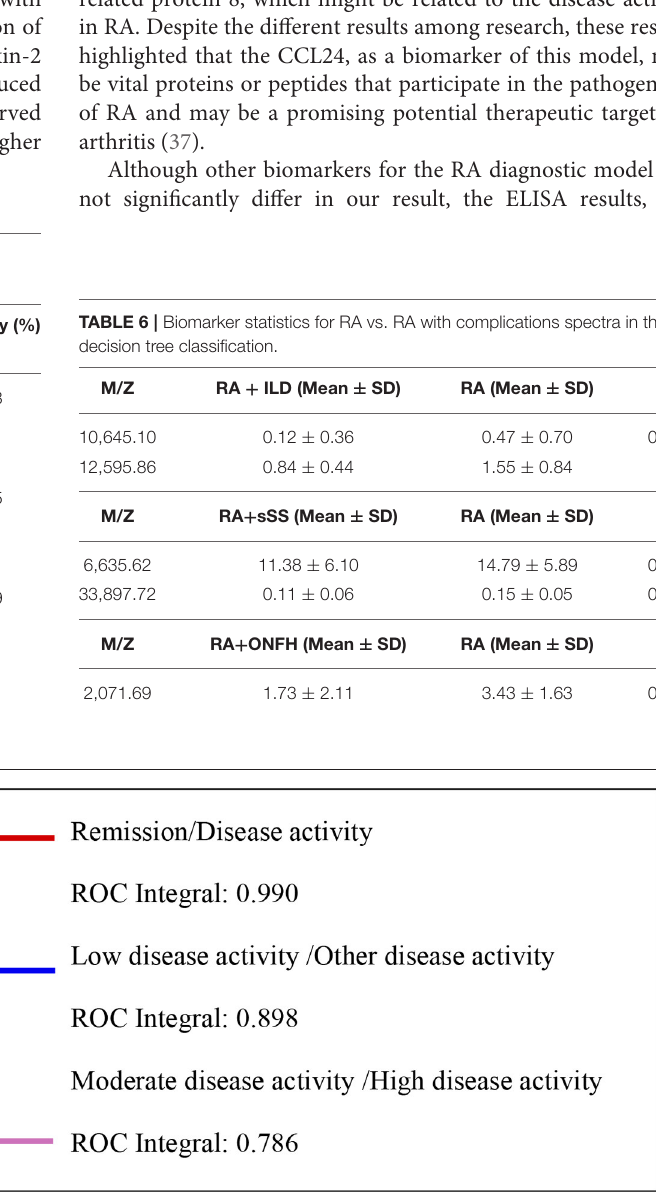
Frontiers in Medicine |